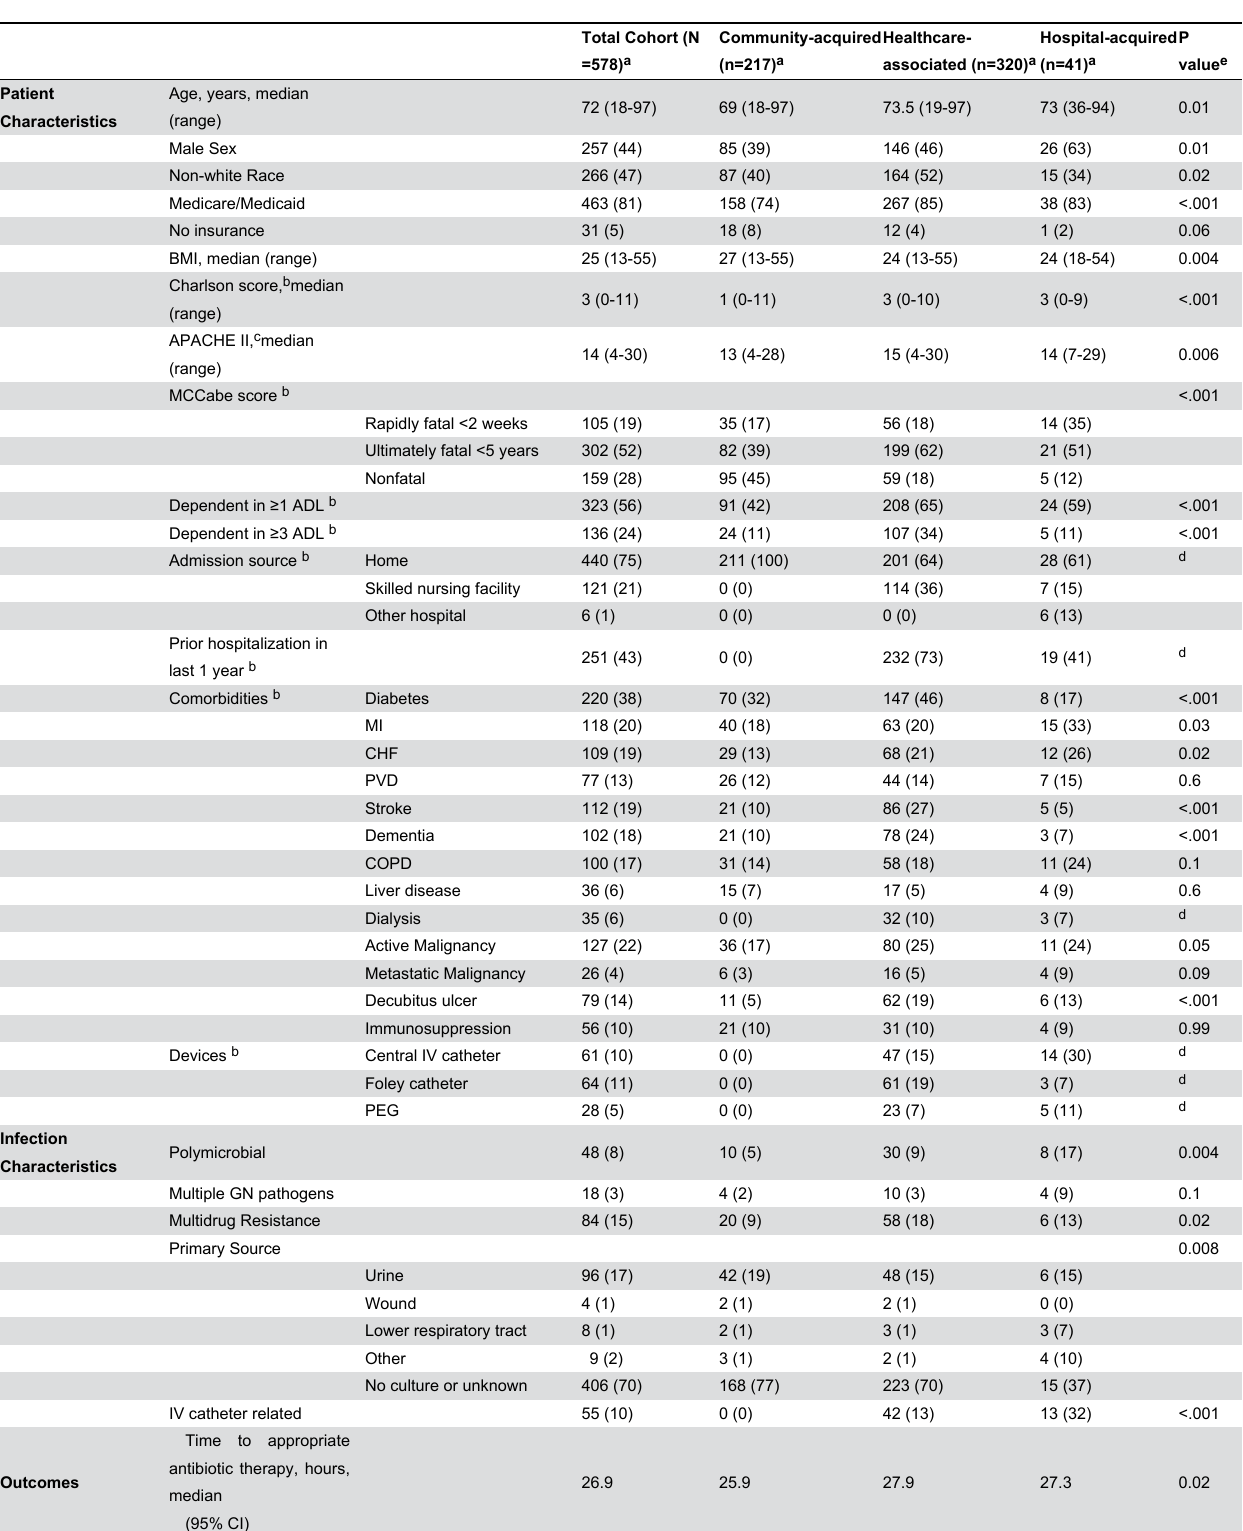
Table 1. Characteristics of Patients by Healthcare Exposure Status.